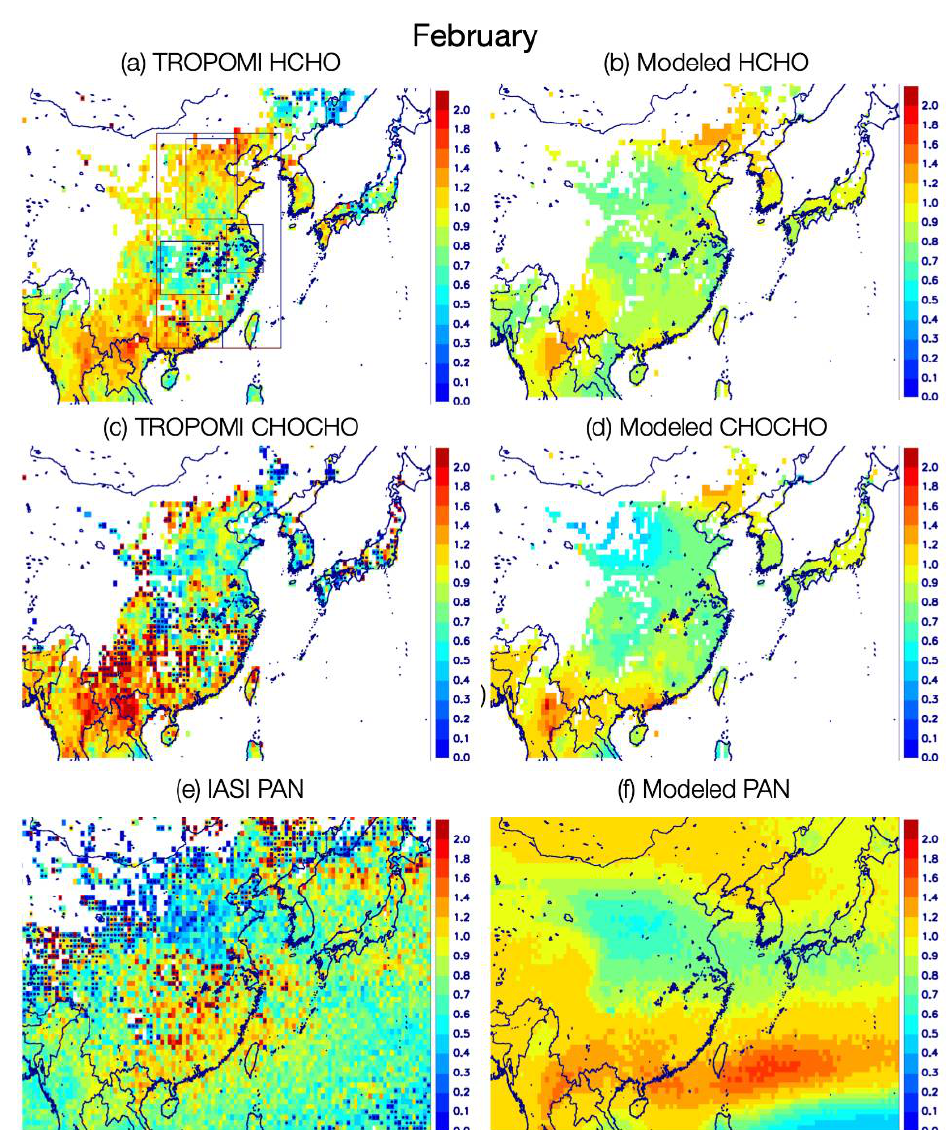
Figure 5. ( a , b ) HCHO column ratio, February 2020 divided by February 2019, according to satellite data ( left ) and to MAGRITTEv1.1 ( right ). ( c , d ) Idem for CHOCHO. ( e , f ) Idem for PAN. Invalid data and areas with very low VOC emissions (less than 5 × 10 10 molec.cm −2 s −1 ) are left blank in panels a–d. The stippling in panels a, c, and e indicates data below the estimated detection limit. The boxes of panel ( a ) indicate the analysis regions (also shown in Figure 4).